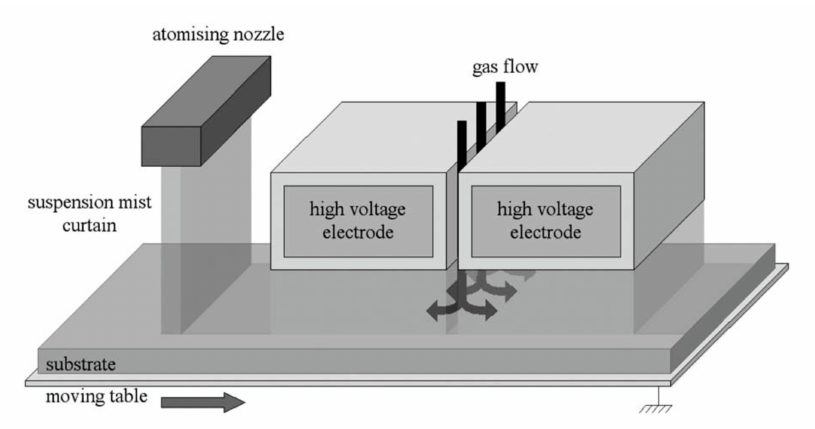
Figure 5. Schematic illustration of the gas-sensing coating deposition from an atomizing nozzle and an AP-DBD. Reprinted with permission from [81]. Copyright 2006 John Wiley & Sons,